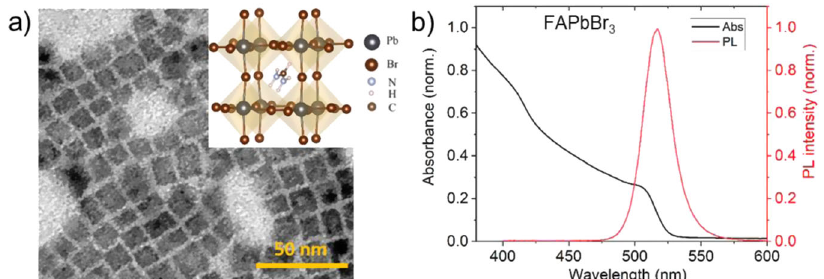
Fig. 1 Morphological and optical properties of FAPbBr 3 PNCs. a TEM image of the FAPbBr 3 PNCs. (Inset) Crystal structure of FAPbBr 3 . b Steady-state optical absorption and PL spectra of the FAPbBr 3 PNCs.